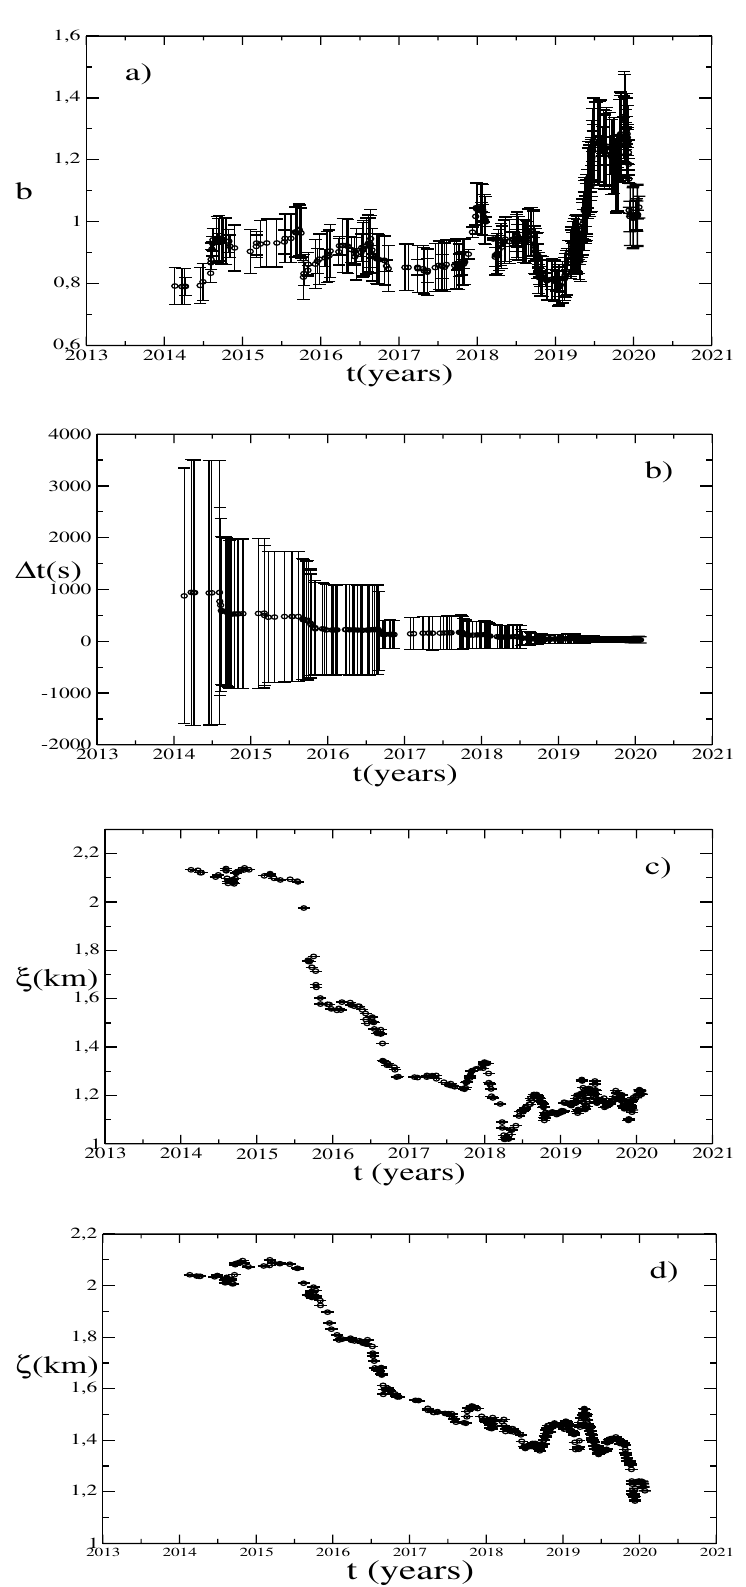
Figure 5. Temporal variation of ( a ) b-value with its standard deviation calculated following 22 ; ( b ) inter-time; ( c ) and ( d ) epicentral inter-distance and average depth, respectively. Error bars represent the standard